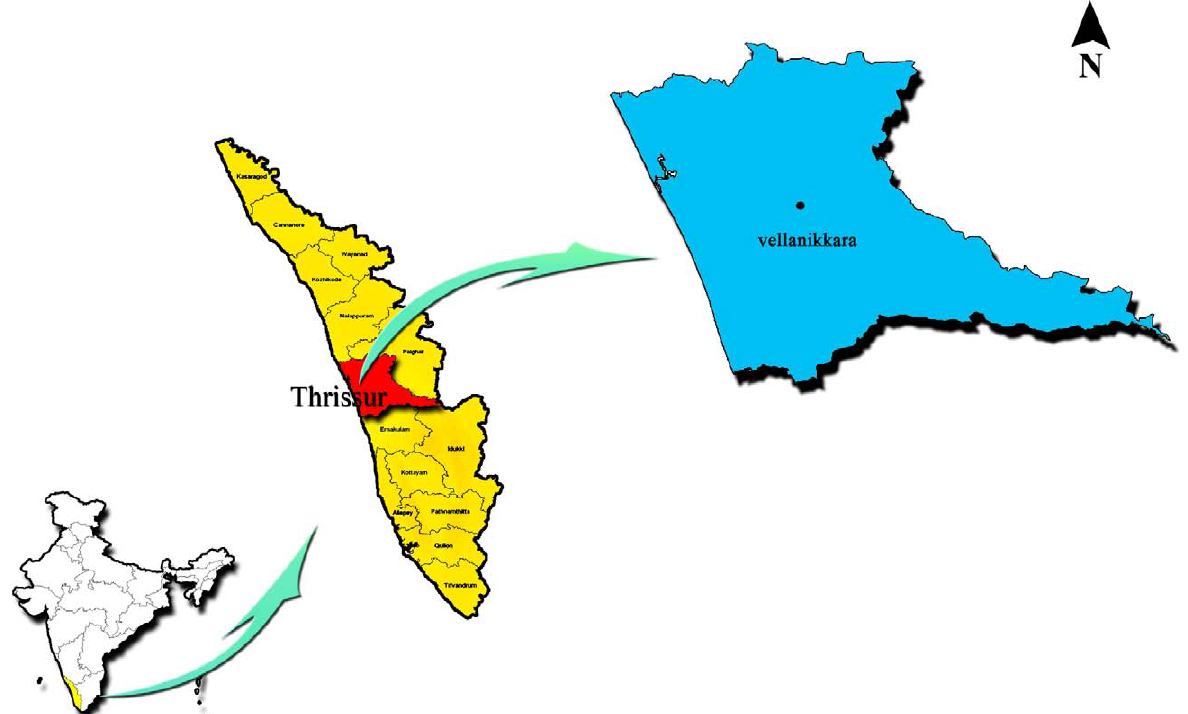
Figure 1. Location map of Kerala Agricultural University campus, Vellanikkara,